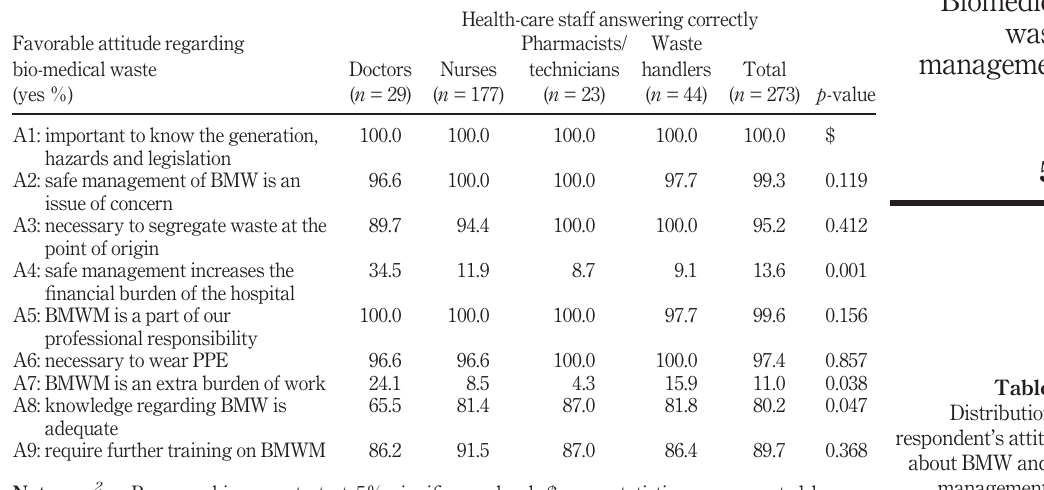
Table 5. Distribution